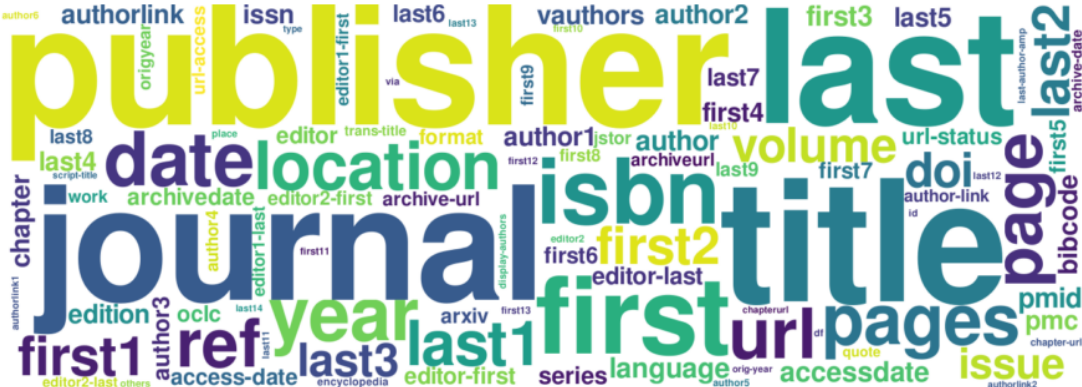
Figure 2. Wikipedia citation templates which describes scientific publications in different languages. Font size shows frequency of use. Source: own study in November 2019.